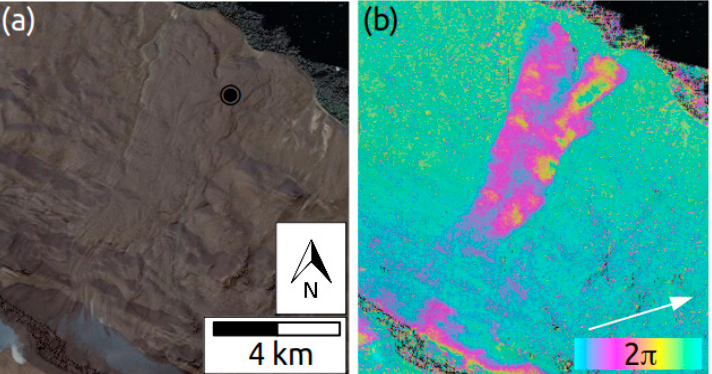
Figure 8. ( a ) Manissuarsuk rock glacier (Qeqertarsuaq, Western Greenland) with position of the Sentinel-1 InSAR time series of Figure 9 (black dot), image data are from Google, DigitalGlobe; ( b ) Sentinel-1 interferogram from 24.01.2019 to 30.01.2019, 2 π ⇔ 2.8 cm. The white arrow indicates the satellite line-of-sight.